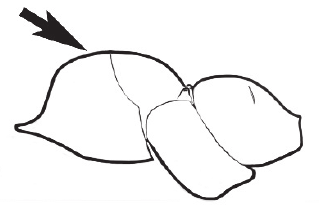
– Minor and media workers, at least, with straight or only weakly sinuous mesonotum; pronotum in minor and media workers moderately (i.e., ≈